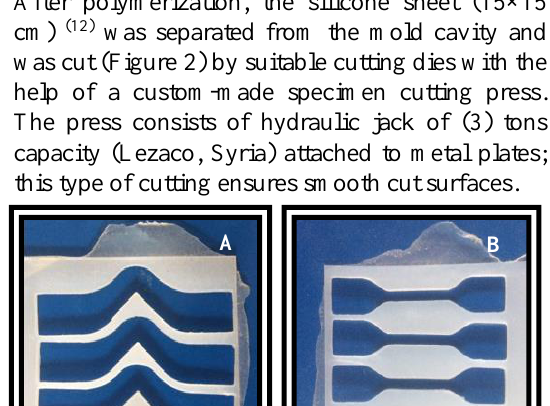
Figure (2): Specimen's preparation through cutting of the silicone sheet. A, tear specimens; B, tensile specimens All specimens were visually inspected for Restorative Dentistry